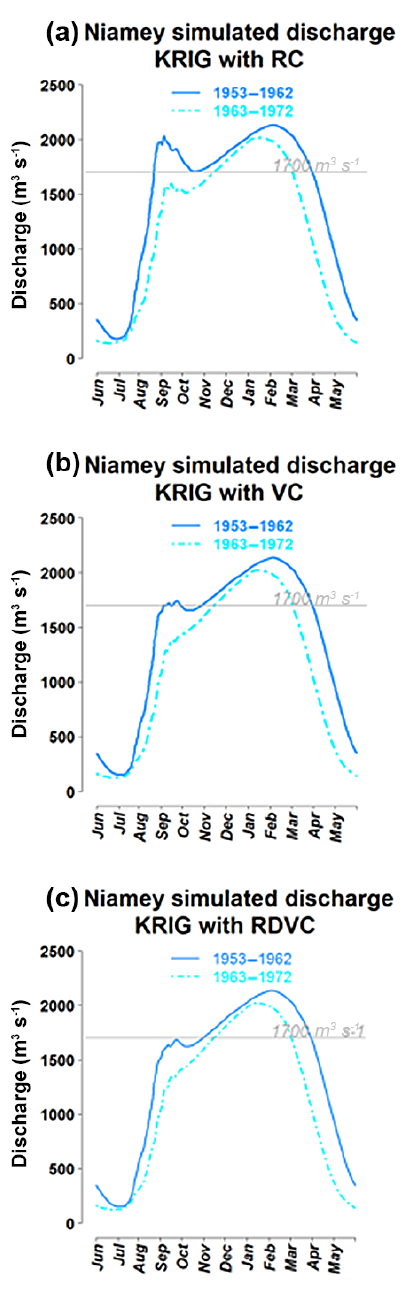
Figure 12. Simulated decadal mean discharge in Niamey with three scenarios : (a) recent surface condition (RC), (b) fully vegetated basin condition (VC) and (c) fully vegetated basin with smaller drainage area condition